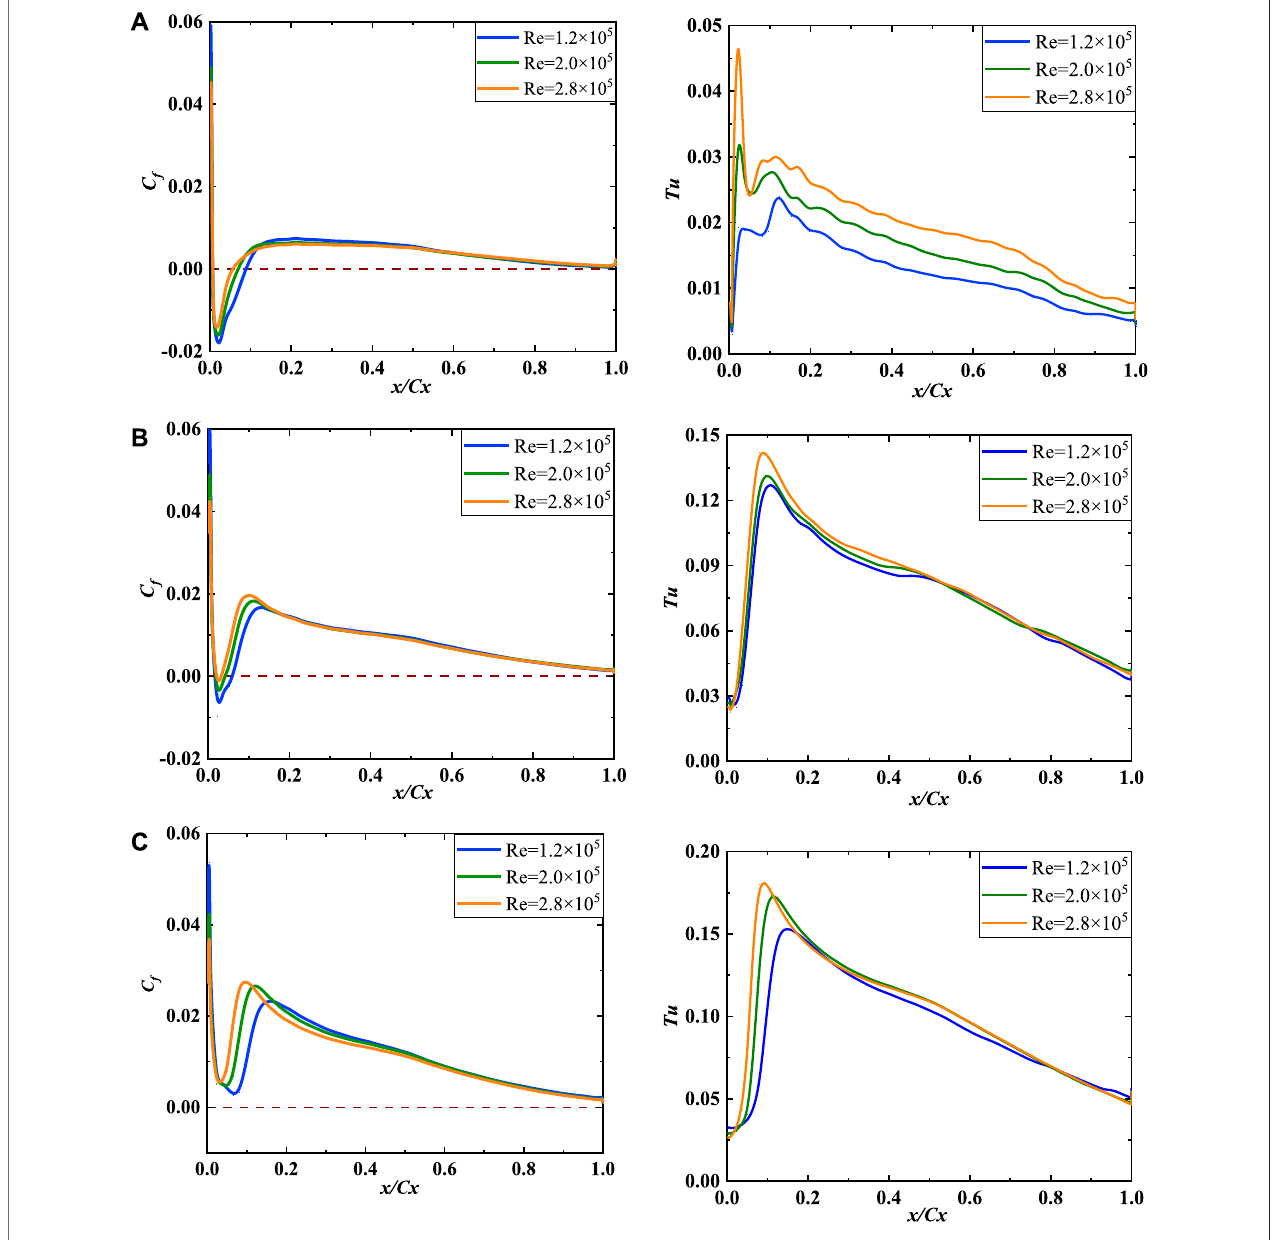
FIGURE 8 | Axial friction coef fi cient and turbulence intensity of cascades under different Reynolds numbers: (A) smooth, (B) 74 μ m, and (C) 180 μ m.